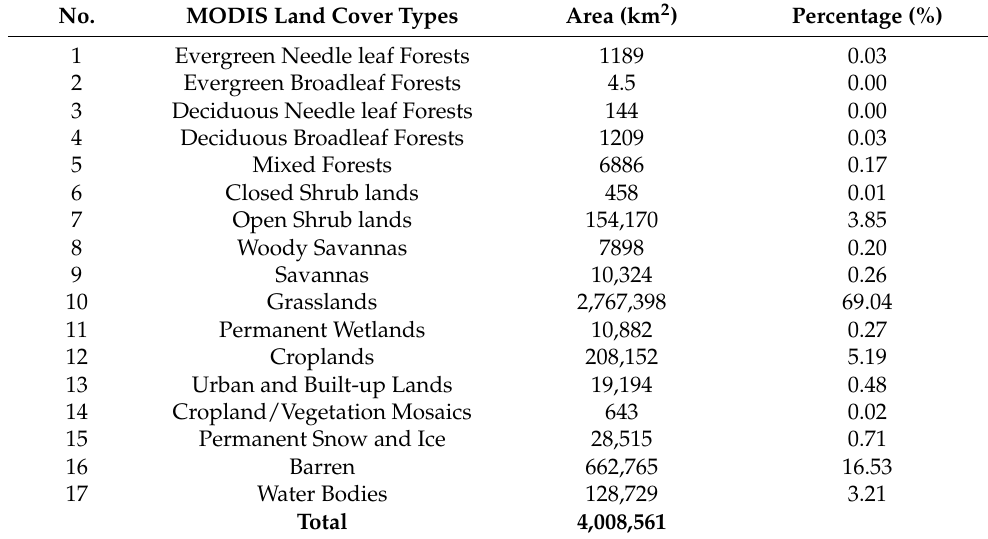
Table 1. Land cover types and percentages for each class in Central Asia.